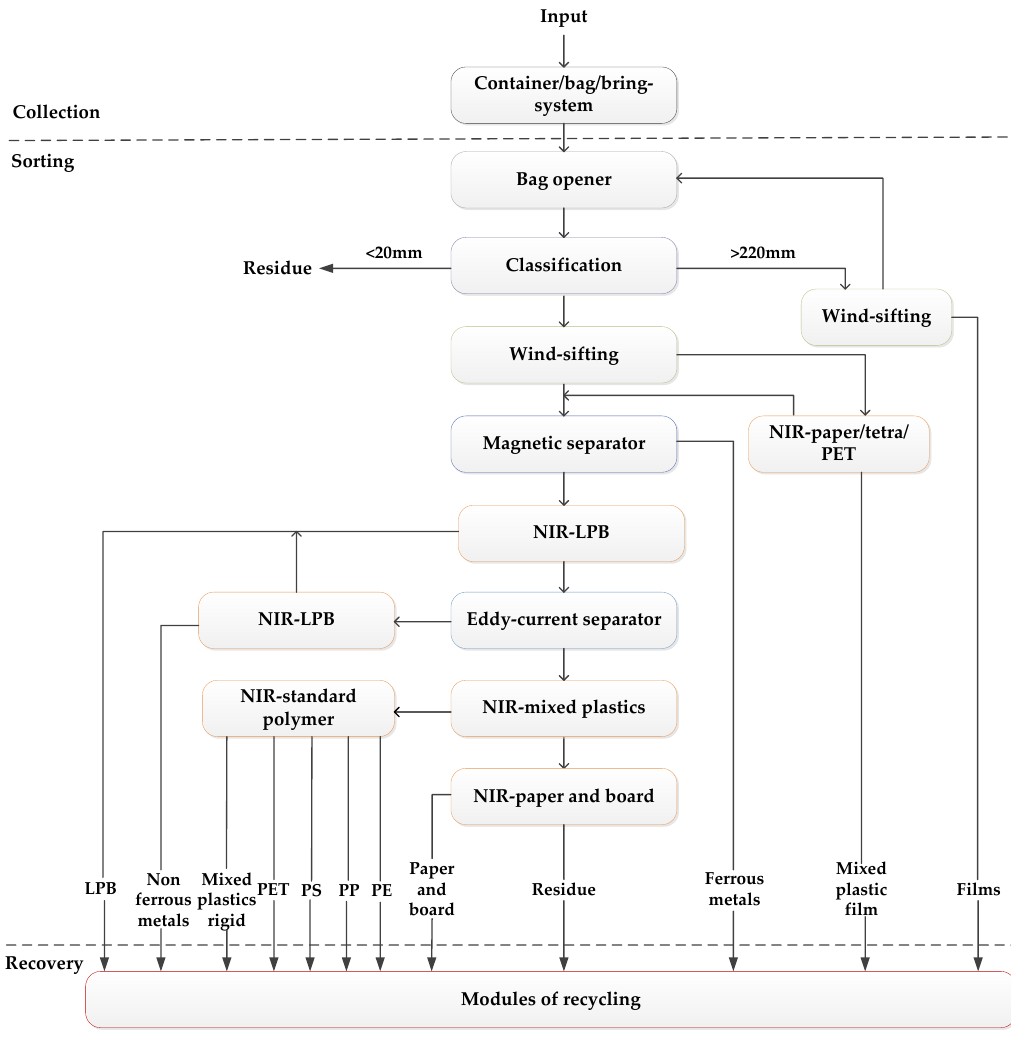
Figure 2. Scheme of a standard state-of-the-art sorting plant. Adapted from [20]. NIR is the abbreviation for near infrared.